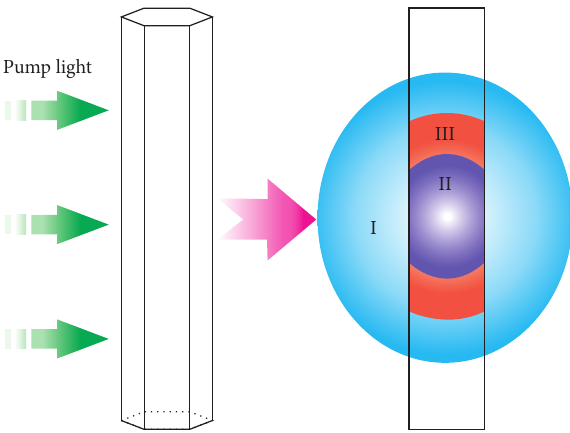
Figure 5: The change of carrier type along the microrod length direction: (I) pump light spot; (II) EHP region; (III) exciton